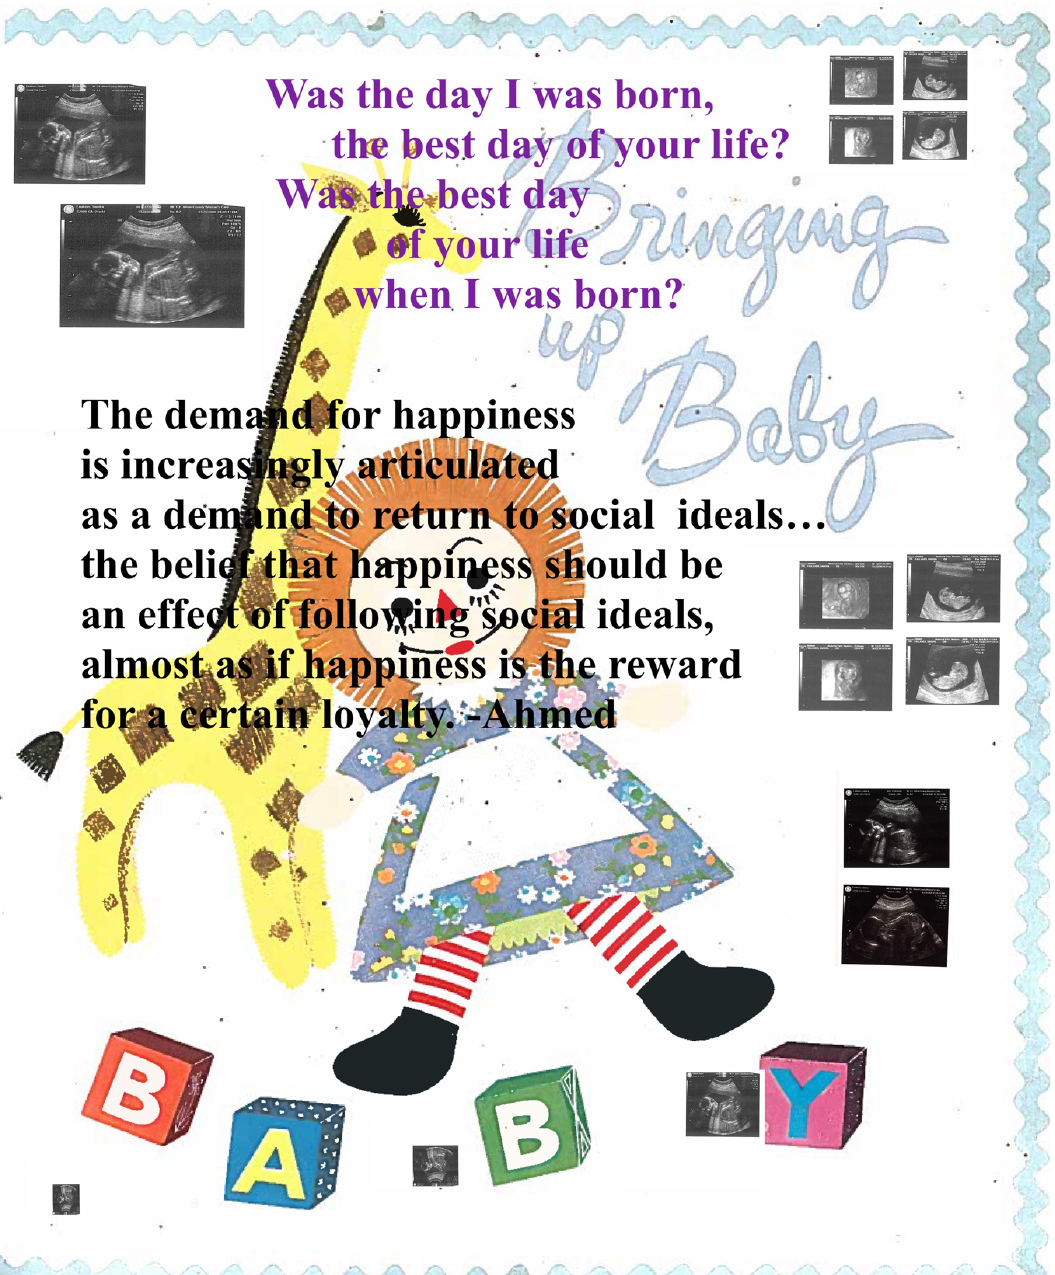
Figure 1. Bringing Up Baby.